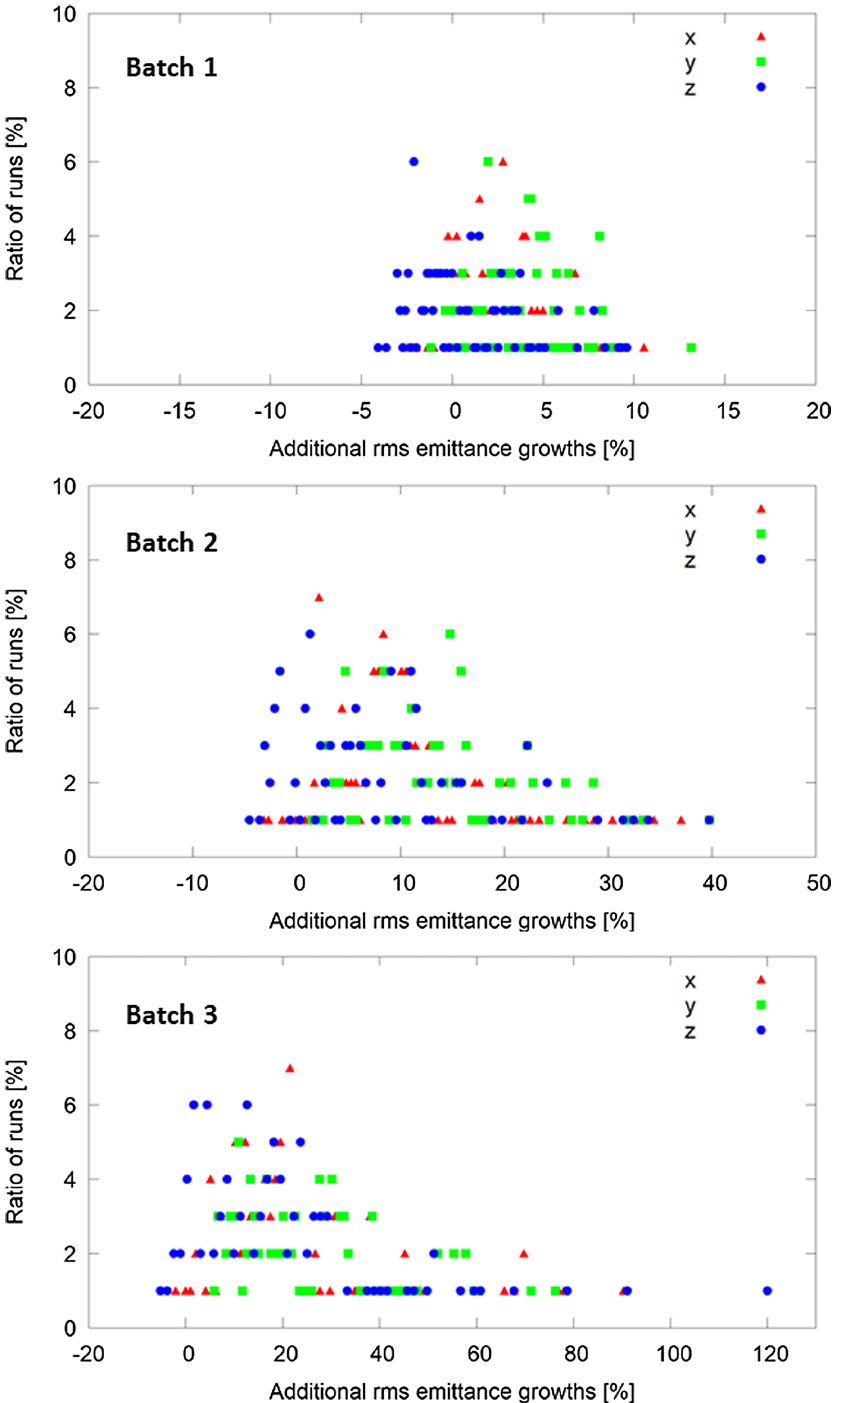
FIG. 16. Additional emittance growths induced by the errors (red, x plane; green, y plane; blue, z